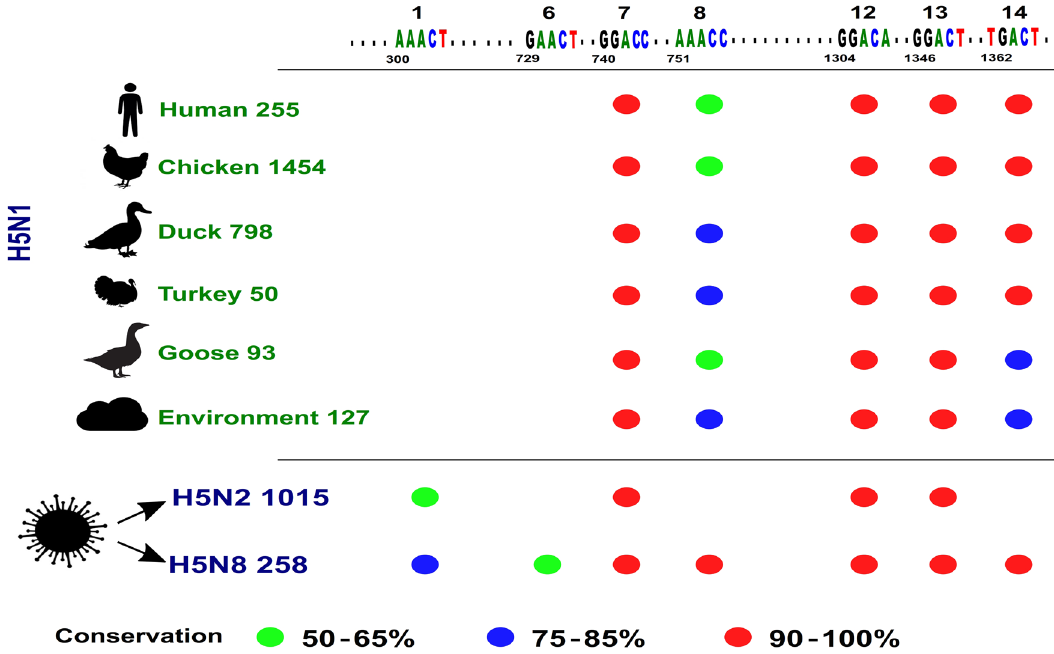
Figure 4. Summary of conserved DRACH motifs among the H5 mRNA. Conserved motifs, virus, host species, and the number of sequences listed on IRD are indicated. The conservation percent is indicated by coloured